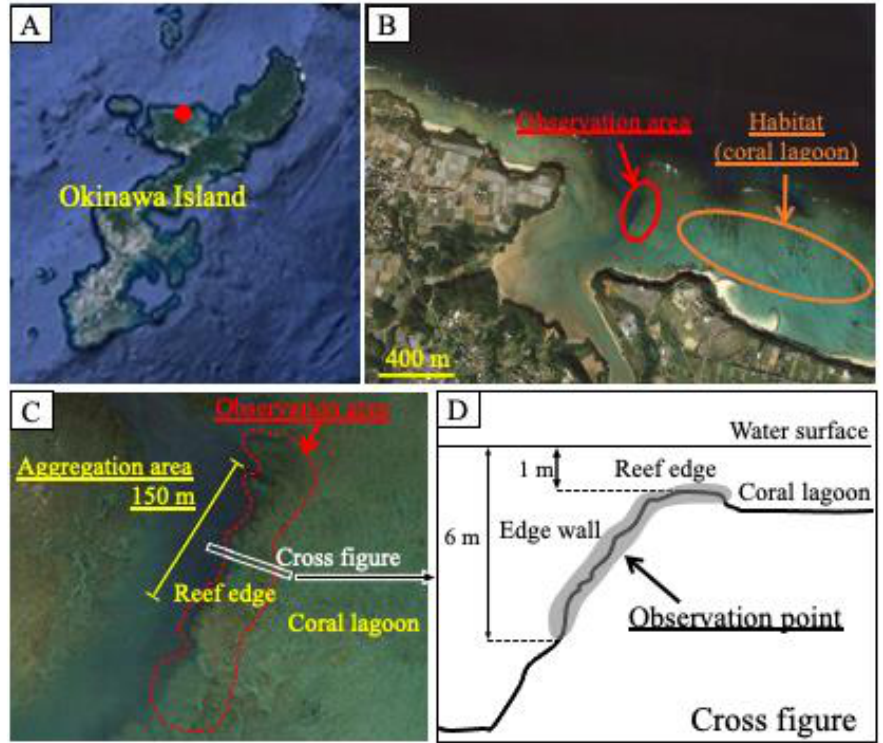
Figure 1. Maps of the observation site on Okinawa Island. ( A , B ) Locations of the observation site (red closed circle in ( A )) and spawning ground (red open circle in ( B )). ( C ) Aggregation area (approximately 150 m) in the spawning ground and observation area (red dotted line). ( D ) Cross-section of the spawning ground indicating the observation area (grey-colored area). These images were captured in Google Earth Pro 2018: http://www.google.com/earth/index.html (accessed on 24 November 2018).